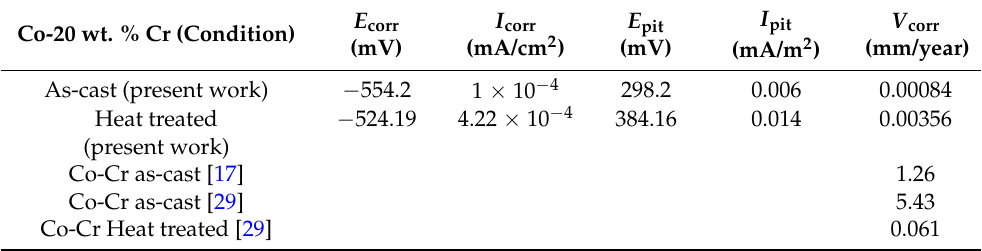
Figure 11. Polarization curves for the Co ‐ 20 wt. % Cr alloys in both, the as ‐ chill cast and the heat treated conditions. Table 3. Electrochemical parameters obtained from the polarization curves of Co ‐ 20 wt. % Cr alloys polarized in Artificial Saliva Solution.